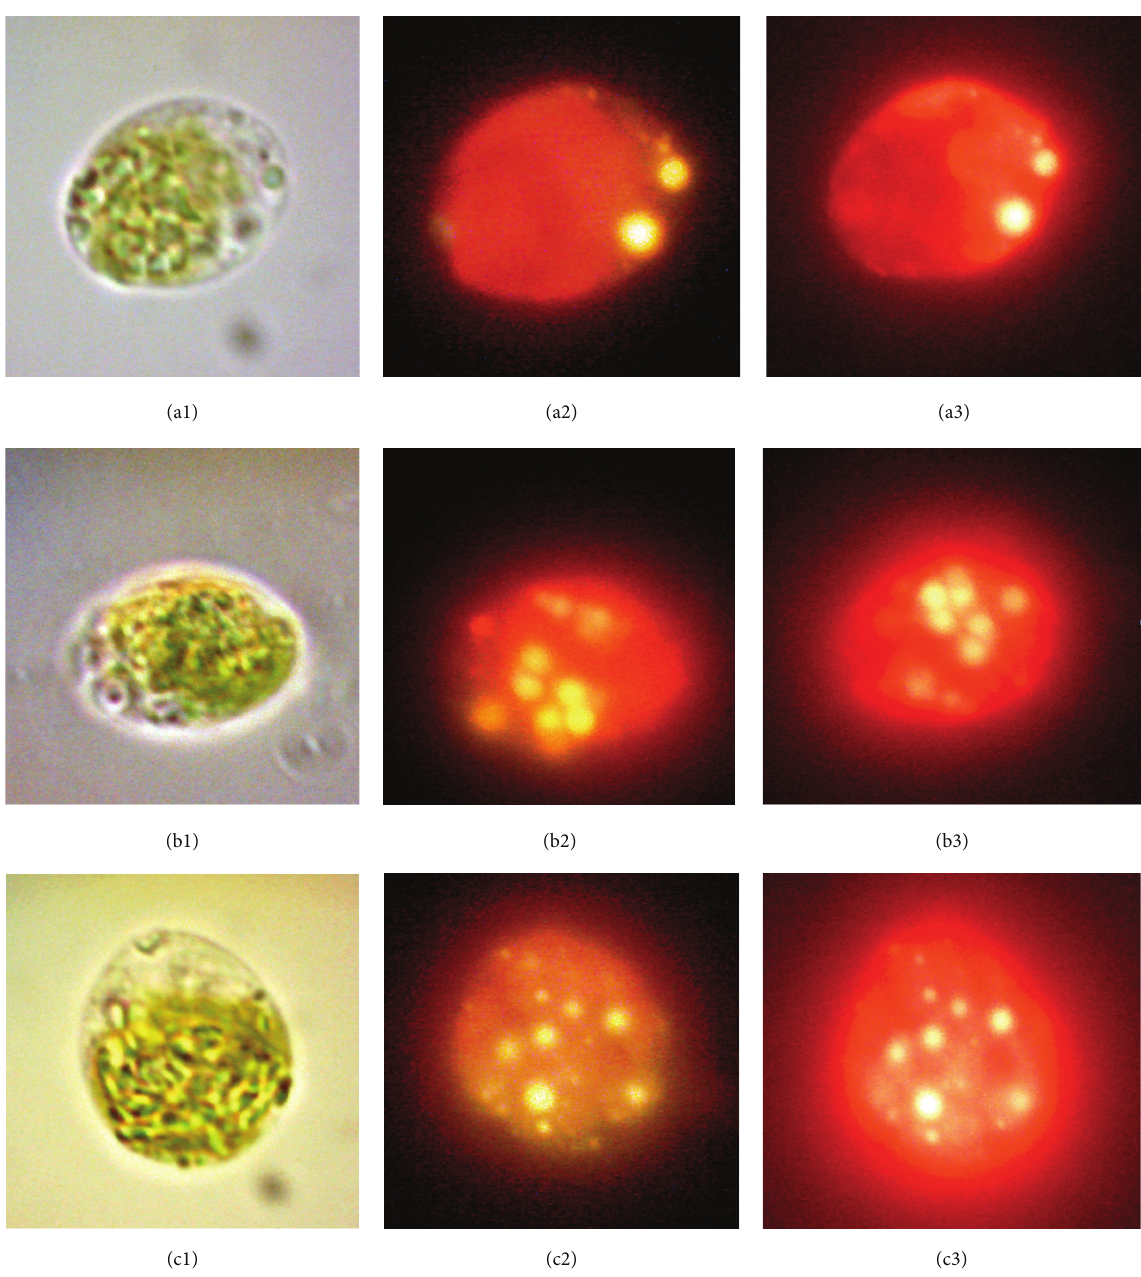
Figure 6: Photomicrographs of 1000x (1) phase contrast, (2) fluorescence of Nile red stained microalga viewed under excitation filter of 355– 425 nm and emission filter of 470 nm, and (3) alternatively, excitation filter of 515–560 nm and emission filter of 590nm of the 2-week old cultures. Red color, chlorophyll autofluorescence; yellow-gold fluorescence (excitation: 355–425 nm) or bright yellow fluorescence (excitation: 515–560 nm), lipid bodies. Samples were cultivated using (a) Walne’s photoautotrophic medium, (b) W-30 + 30 g/L glucose, and (c) ANN- based optimized